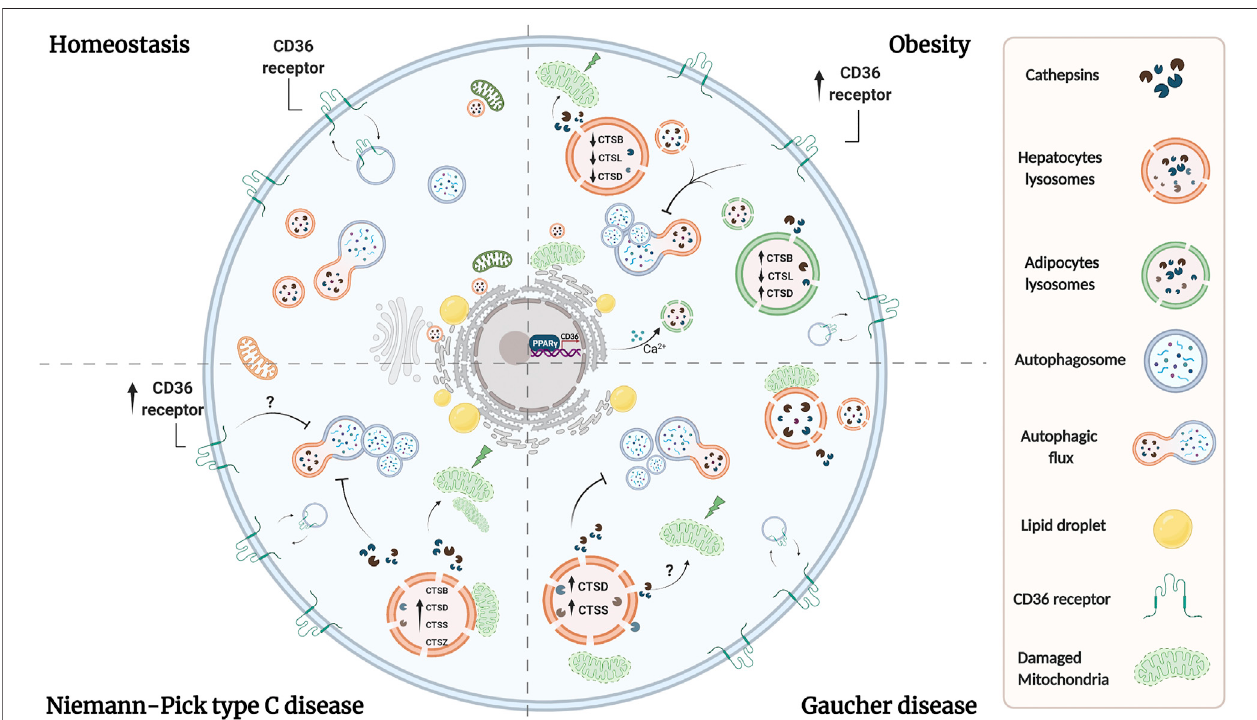
FIGURE 1 | Lysosomal dysfunction coexists in adipocytes and hepatocytes in lipid-related disorders. Overload of lipids induces permeabilization of lysosomal membrane in both adipose and liver tissues, leading to the release of lysosomal proteases. Reports have shown that cytosolic proteases increase ROS production and induce mitochondrial dysfunction, triggering apoptosis and liver injury. Whether similar alterations exist in adipocytes under these conditions, remains to be evaluated. Additionally, a imbalance in cathepsins levels exists in both tissues in obesity. Overall, obesity is associated with oxidative stress, which lead to alkalinization of lysosomalpH,causingtheaccumulationofautophagosomes, andsuppressionofautophagicclearance.InNPCandGaucherdiseasestherearealterationsinthelevels or activity of cathepsins which are associated with proteolytic impairment and inhibition of autophagy, which altogether contribute to lysosome dysfunction probably by analogous mechanisms as those observed in obesity. On the other hand, dyslipidemia is associated with an increase in the expression of CD36 in adipocytes and hepatocytes,whichleadsalsotoanincreaseinlysosomalpHandaninhibitionofautophagy.Inadipocytes,CD36mediateslysosomalcalciumoverloadthroughtheER, and we speculate that a similar mechanism could occur in hepatocytes. Additionally, lipid uptake is mediated by an increase in CD36 expression in adipocytes and hepatocytes by PPAR- c , which promotes lipid accumulation and contributes to lysosome dysfunction. Although the upregulation of CD36 in NPC liver has been observed, its role in NPC and Gaucher hepatic diseases remains